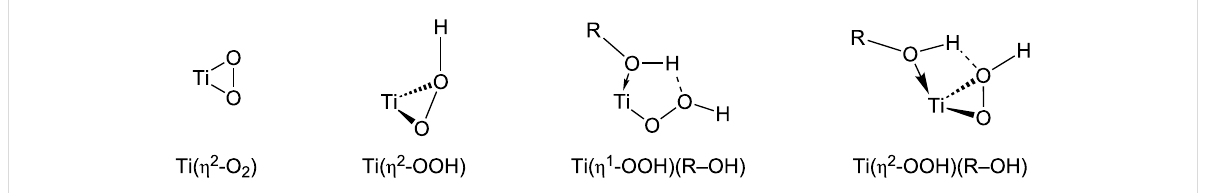
Figure 11: Different oxo-titanium species in TS-1. R–OH is a co-adsorbed alcohol molecule, stabilizing the hydroperoxide complex.